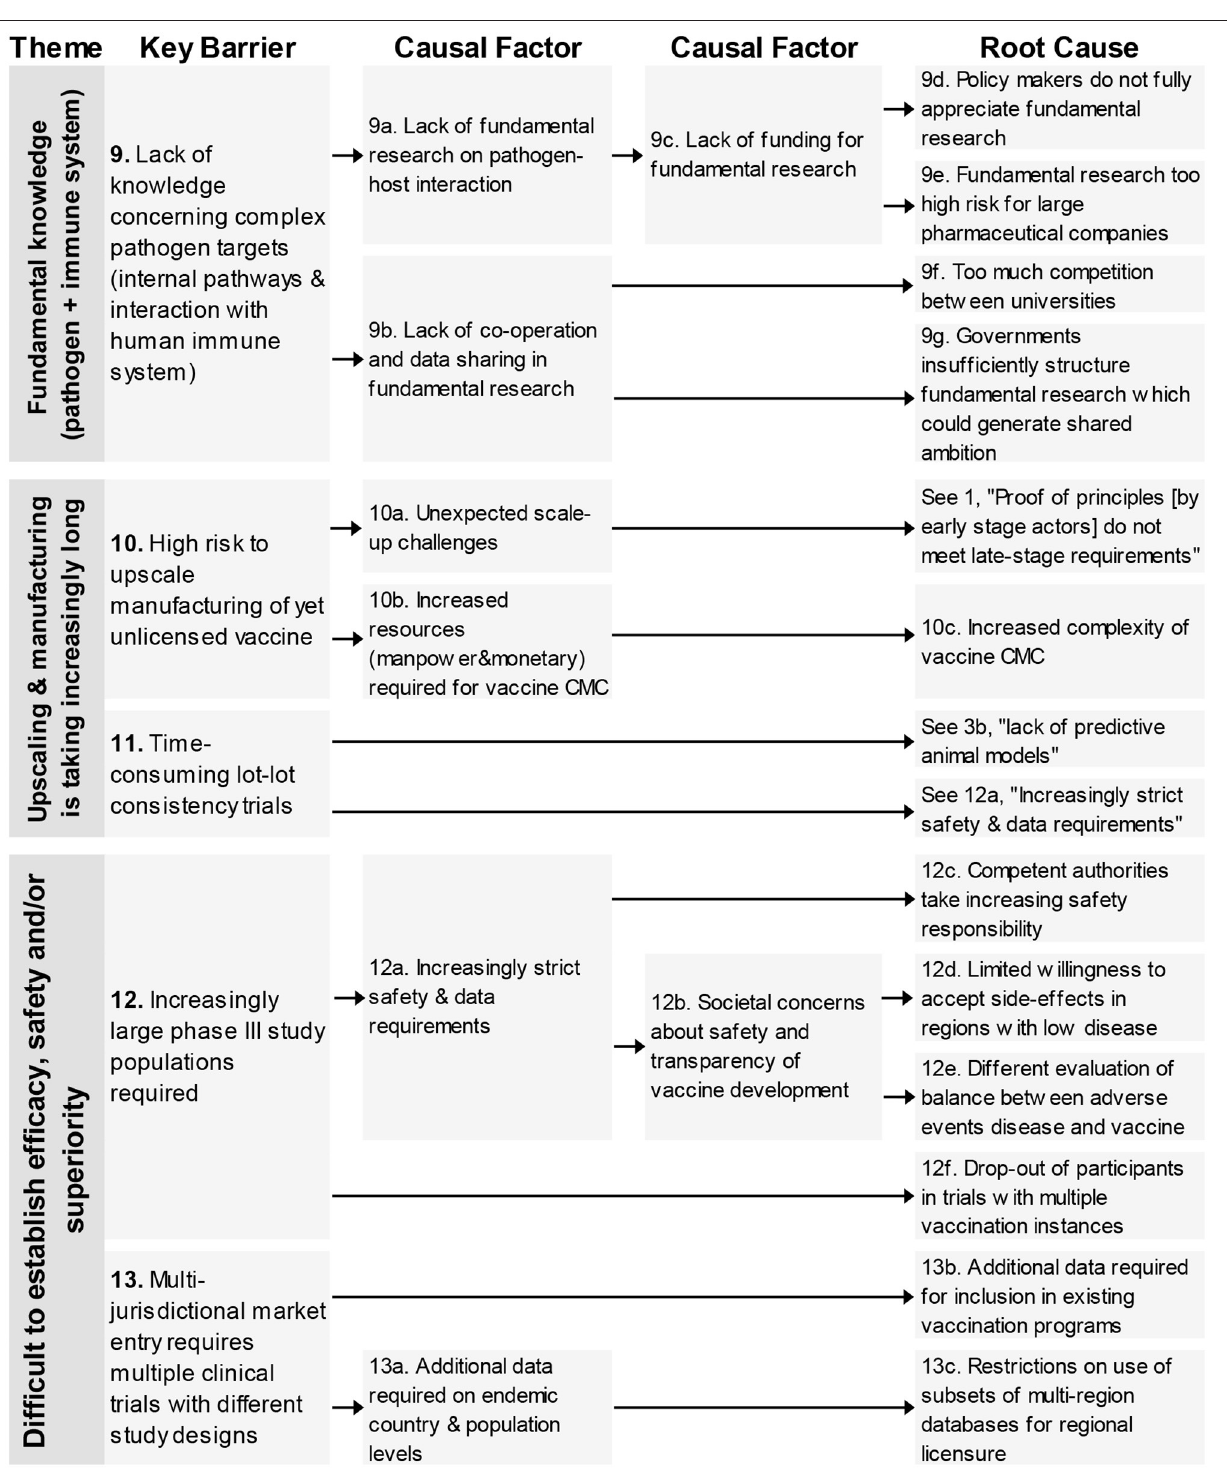
Frontiers in Public Health |